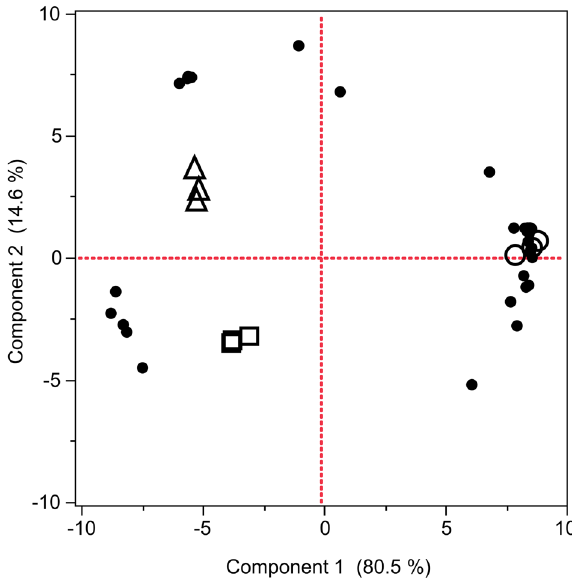
Fig. 3 Principal component analysis (PCA) biplot of the aroma compounds in the EVOO. The peak areas of the aroma compounds were used to generate the PCA biplot. The number of aroma compounds obtained using the three methods, OA-LLE + SAFE, SAFE, and HS-SPME, was 41, 20, and 23, respectively. The closed black circles ( ● ) indicate each aroma compound listed in Table 2, and the open circles ( ○ ), open squares ( □ ), and open triangles ( △ ) indicate OA-LLE + SAFE, SAFE, and HS-SPME, respectively. Each extraction was performed in